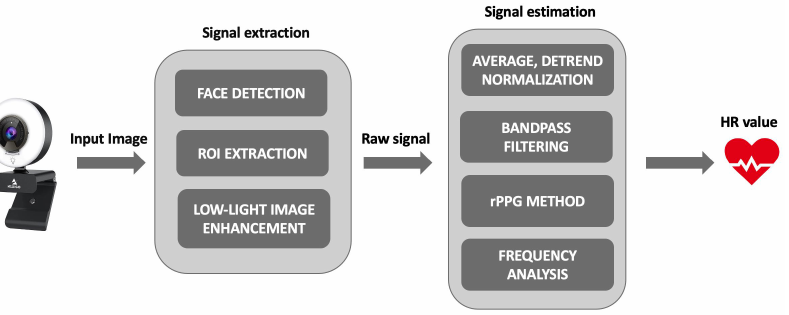
Figure 4. Graphical representation through a block diagram of the pipeline designed and imple- mented for HR estimation by a plethysmographic signal extracted from the face of an